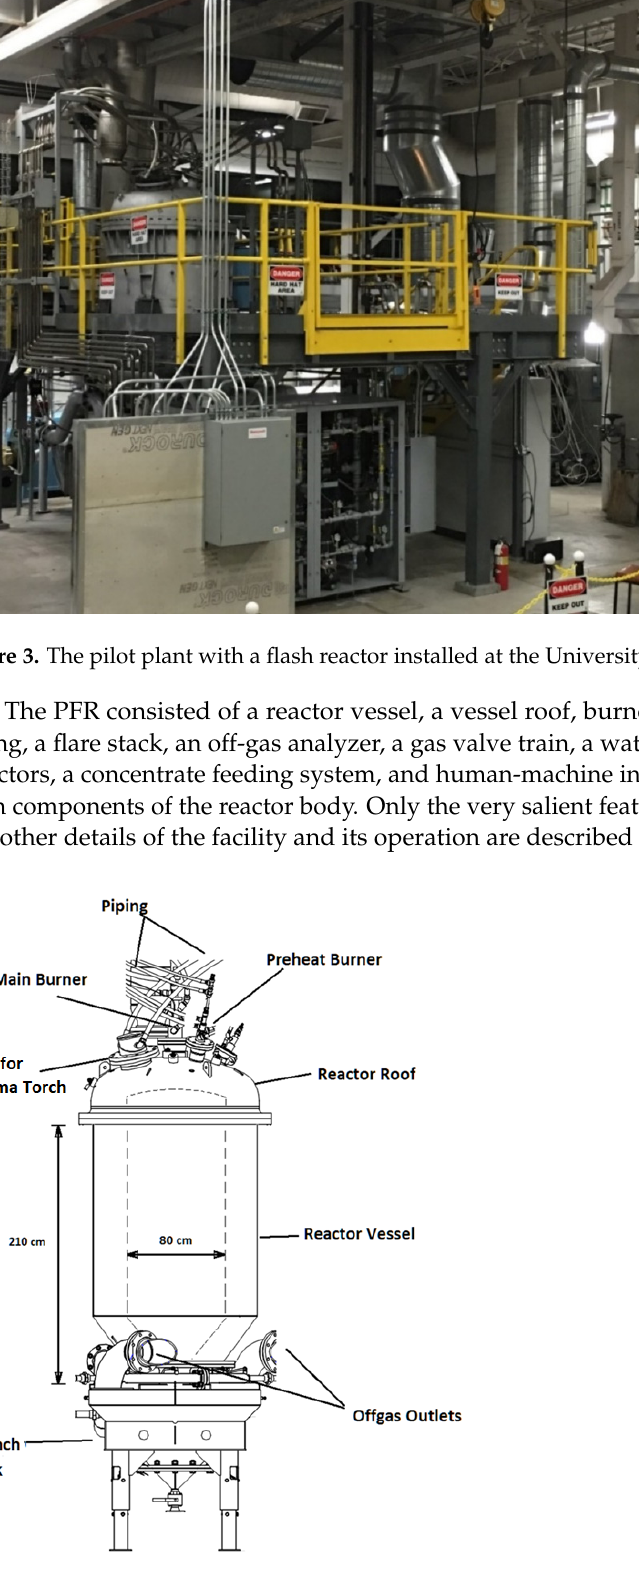
Figure 4. Schematic diagram of the pilot flash reactor (PFR).